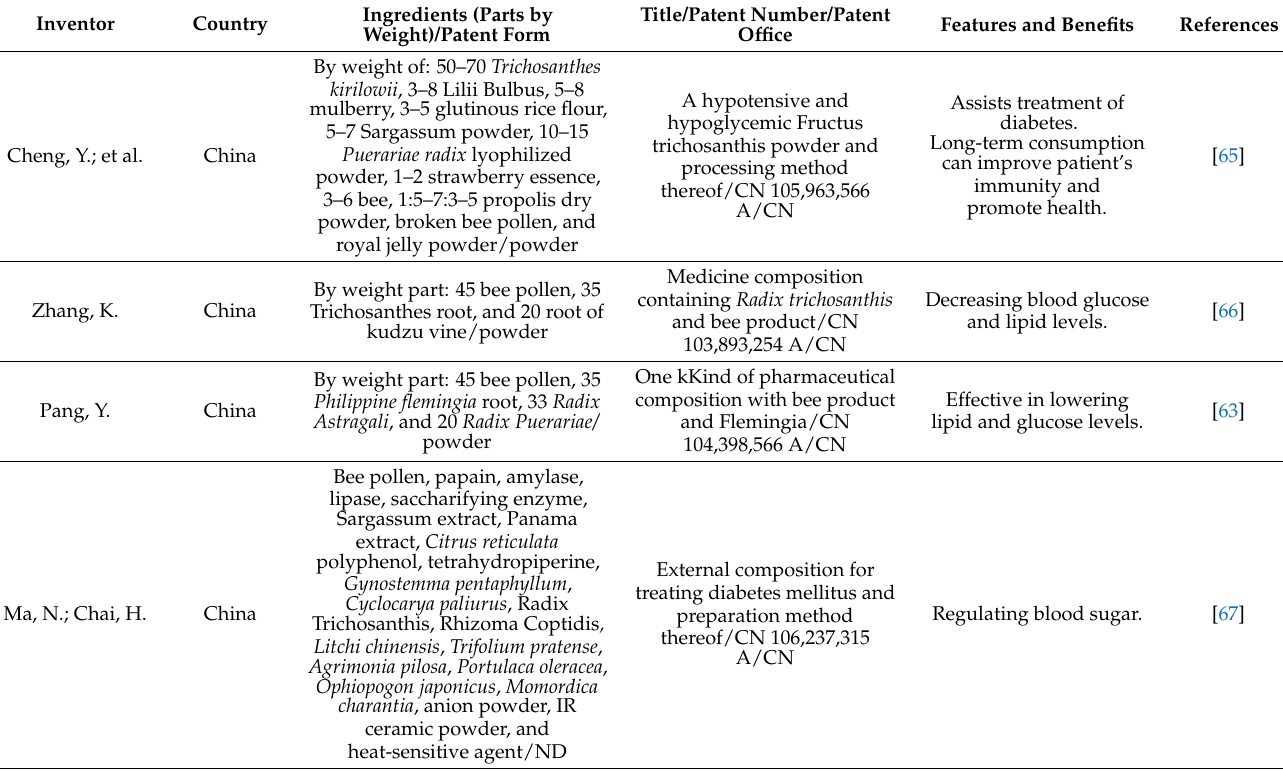
Table 2. Different forms of bee pollen for diabetic